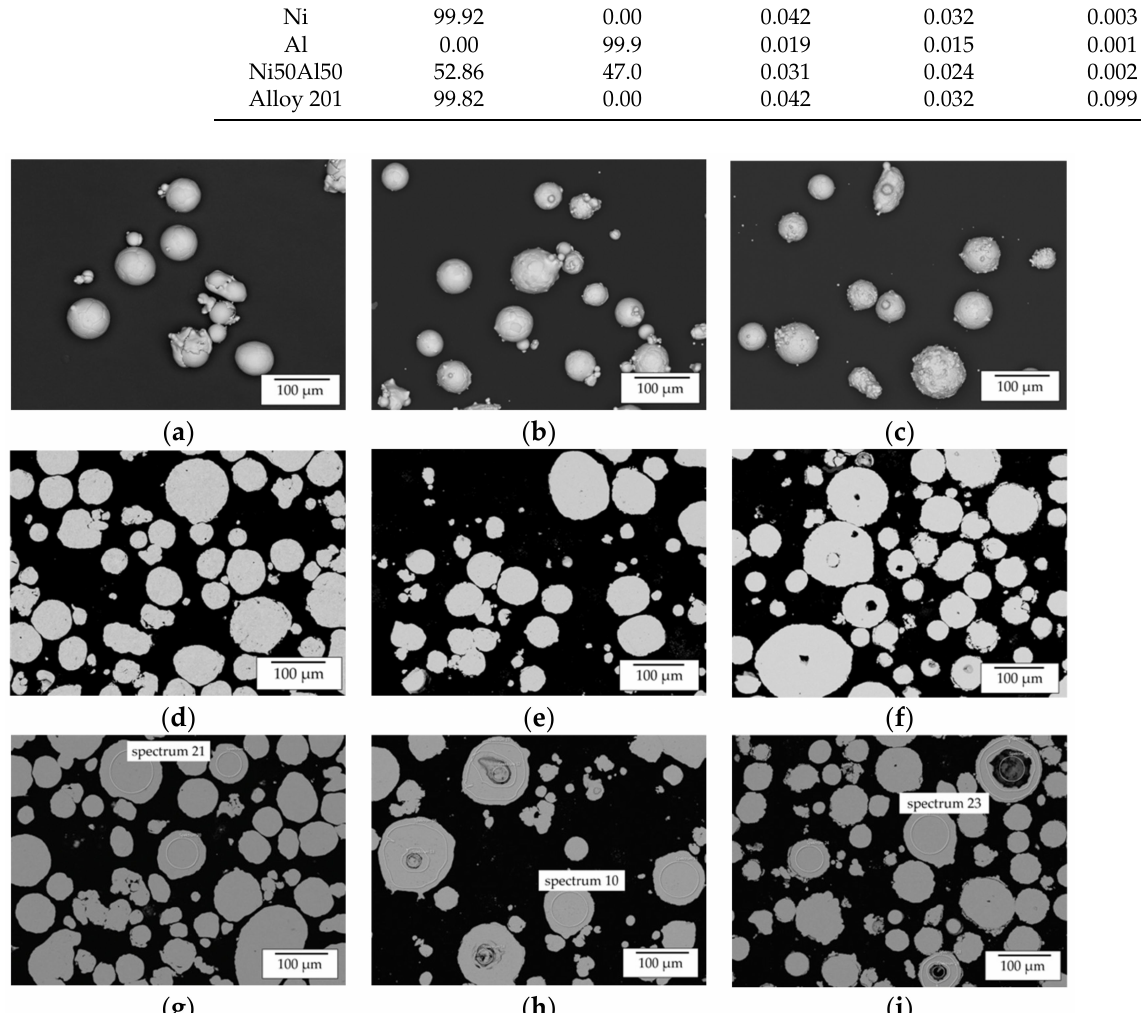
Figure 3. Overview of SEM images of the used powder material—( a – c ) SEM of loose powder particles ( a —Al, b —Ni; c —NiAl); ( d – f ) SEM of powder particle cross sections ( d —Al, e —Ni; f —NiAl); ( g – i ) SEM of powder particle cross sections with marked regions, which were analyzed by EDX ( g —Al, h —Ni; i